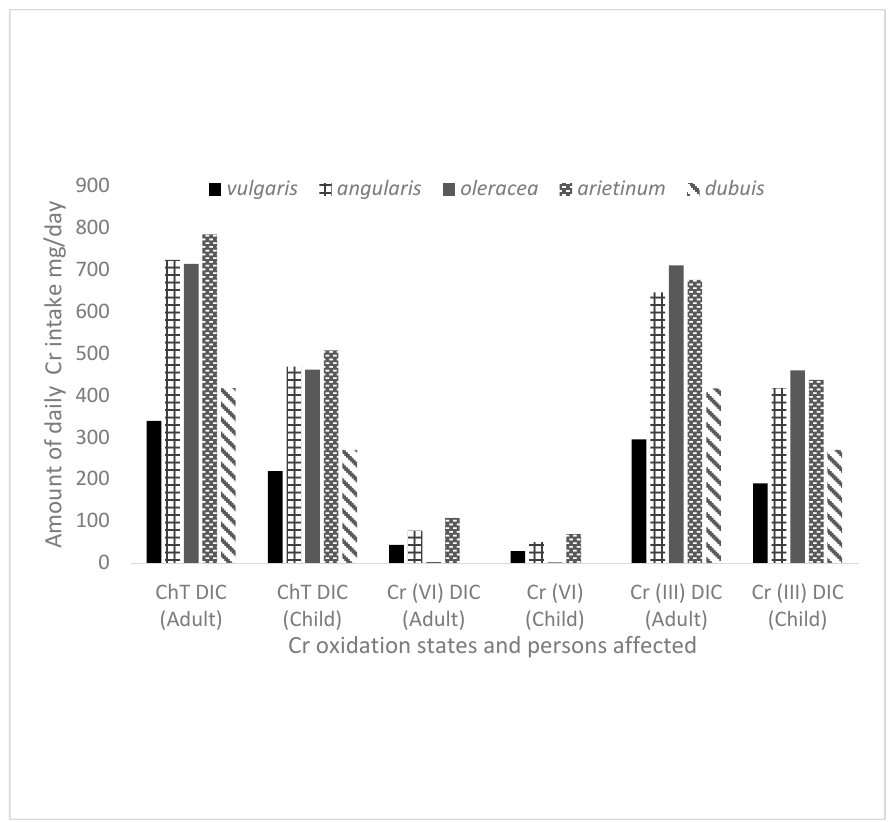
Figure 5. Daily intake of Chromium (DIC) total chromium (Ch T ), Cr(VI) and Cr(III) from the leaves of different vegetables from soil spiked with Cr(VI).